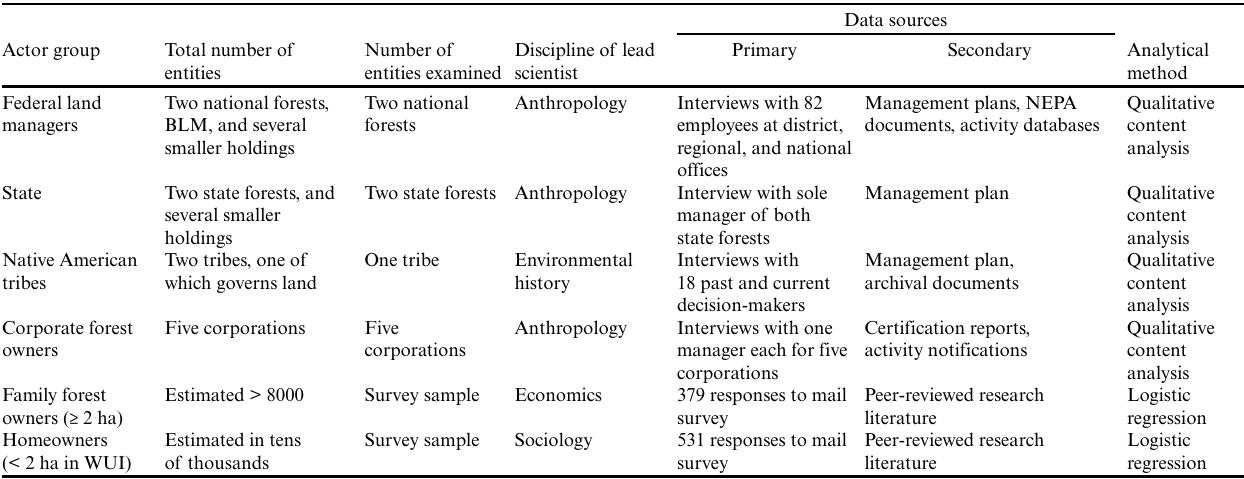
Table 1 . Primary actor groups identified, specific entities examined, and approaches to data collection and analysis (WUI: wildland– urban interface; BLM: Bureau of Land Management; NEPA: National Environmental Policy